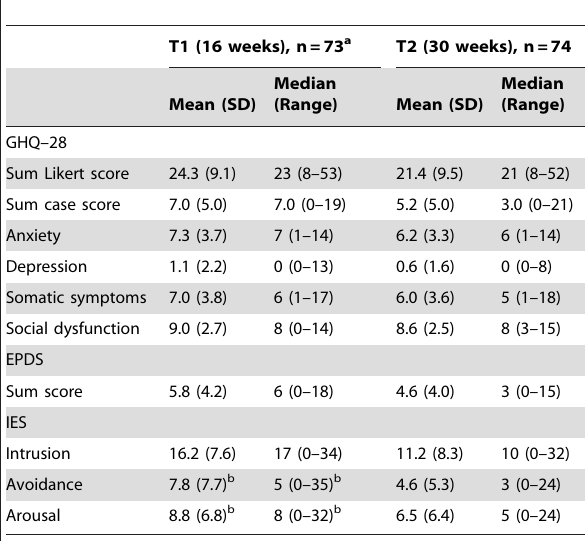
Table 2. Psychological ordinal distress scores at 16 and 30 weeks of gestational